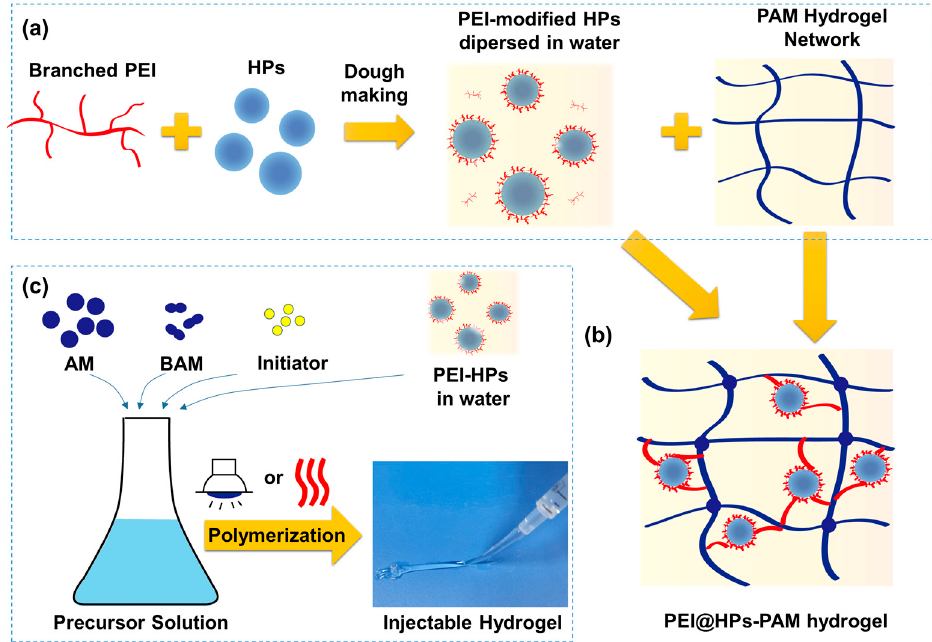
Figure 2. Schematic illustrations of ( a ) combining branched PEI, HPs, and PAM network and ( b ) injectable PEI@HPs-PAM hydrogel network. ( c ) Scheme of preparing PEI@HPs/PAM hydrogel via UV irradiation or heating.